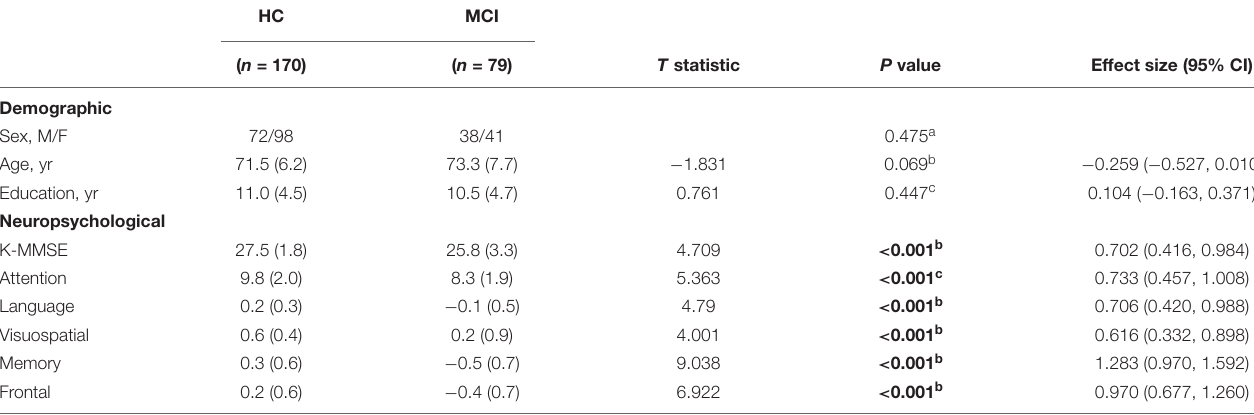
TABLE 1 | Participant’s demographic information and neuropsychological